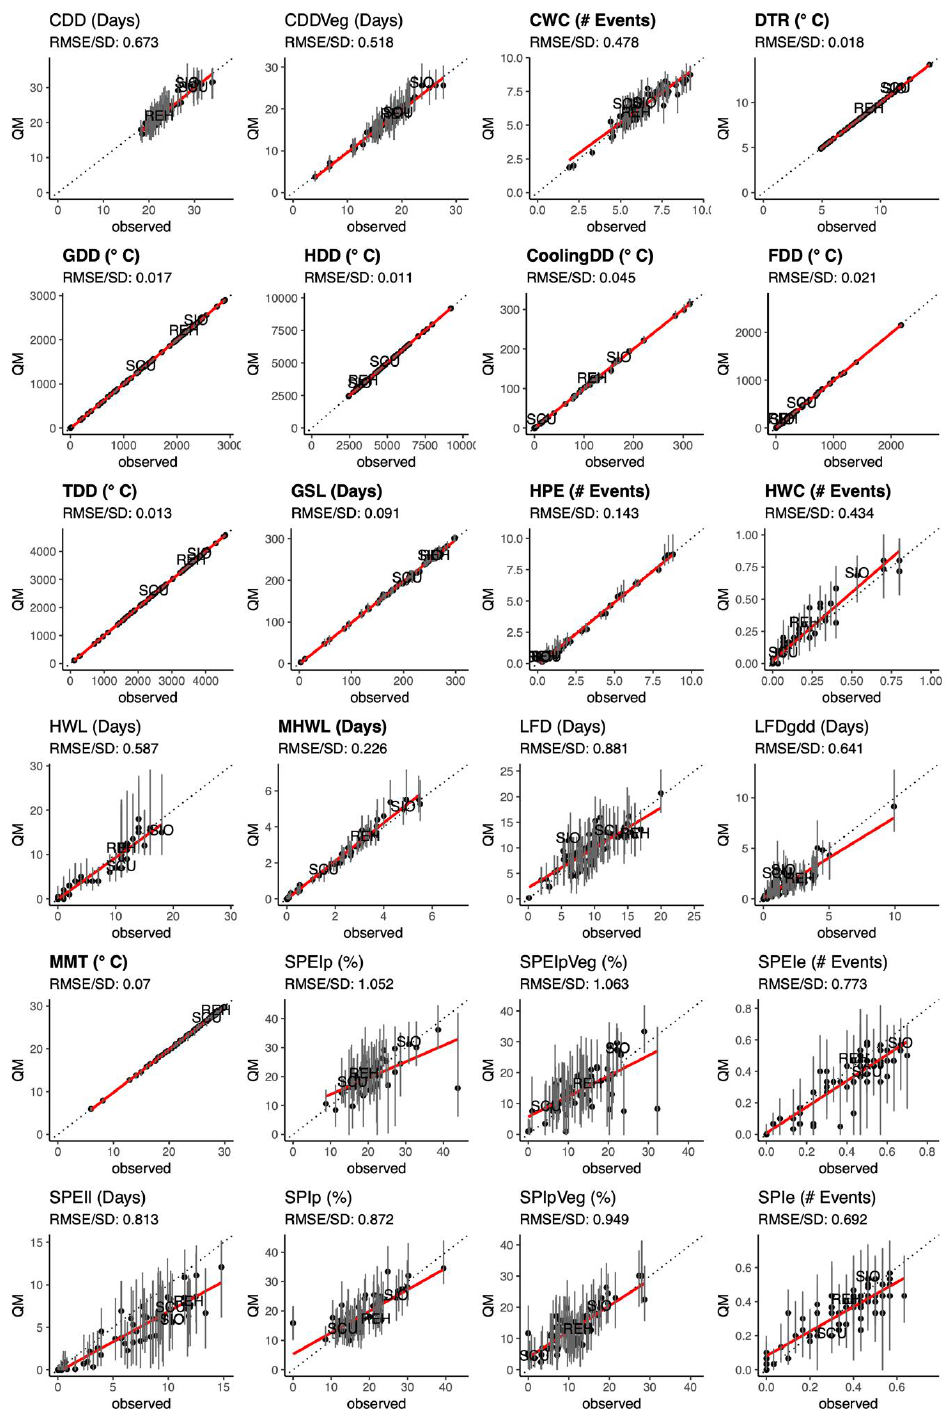
Figure 2. Validation of the 24 indices, shown as scatter plots of observed (x-axis) and quantile mapped (y-axis) values in the historical time period. The standardized RMSE divided by the standard deviation of observed values across stations is used as a performance metric and is indicated in the panel headers. Bold title for class A (RMSE / SD < 0.5) respectively plain for class B indices (RMSE / SD > 0.5). Vertical bars represent the range (5th to 95th quantile) of simulated (quantile-mapped) index values across all individual climate model chains considered per station. Three representative stations for Switzerland’s agricultural climate are tagged in each plot: Sion (SIO), Zurich / Reckenholz (REH) and Scuol (SCU). The solid red line represents the linear trend, the grey dashed line indicates the perfect correlation between observed and QM data (1:1